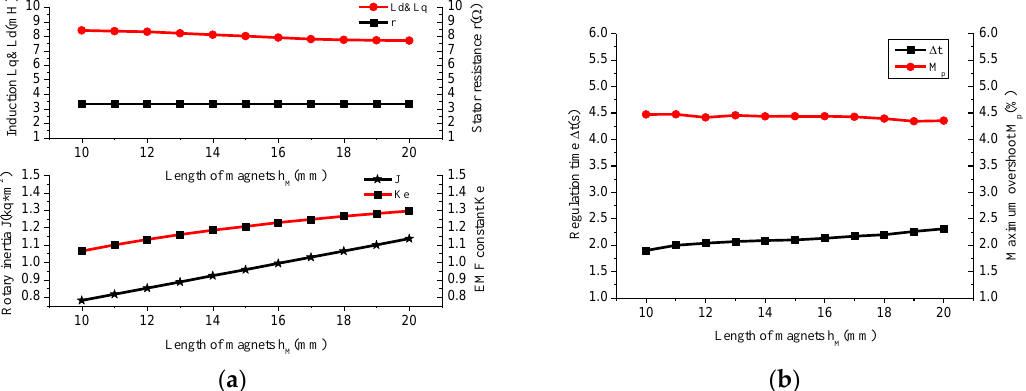
( b ) Figure 8. Influence of different diameter ratio: ( a ) Model variables; ( b ) Dynamic characteristic response. 3.2.2. Thickness of the Permanent Magnet The permanent magnet (PM) is the source of the magnetic field and it is also a part of the magnetic circuit. The electrical time constant as well as the EMF factor and inductance is affected due to the magnetic resistance being closed to air. The EMF factor and rotational inertia increases while